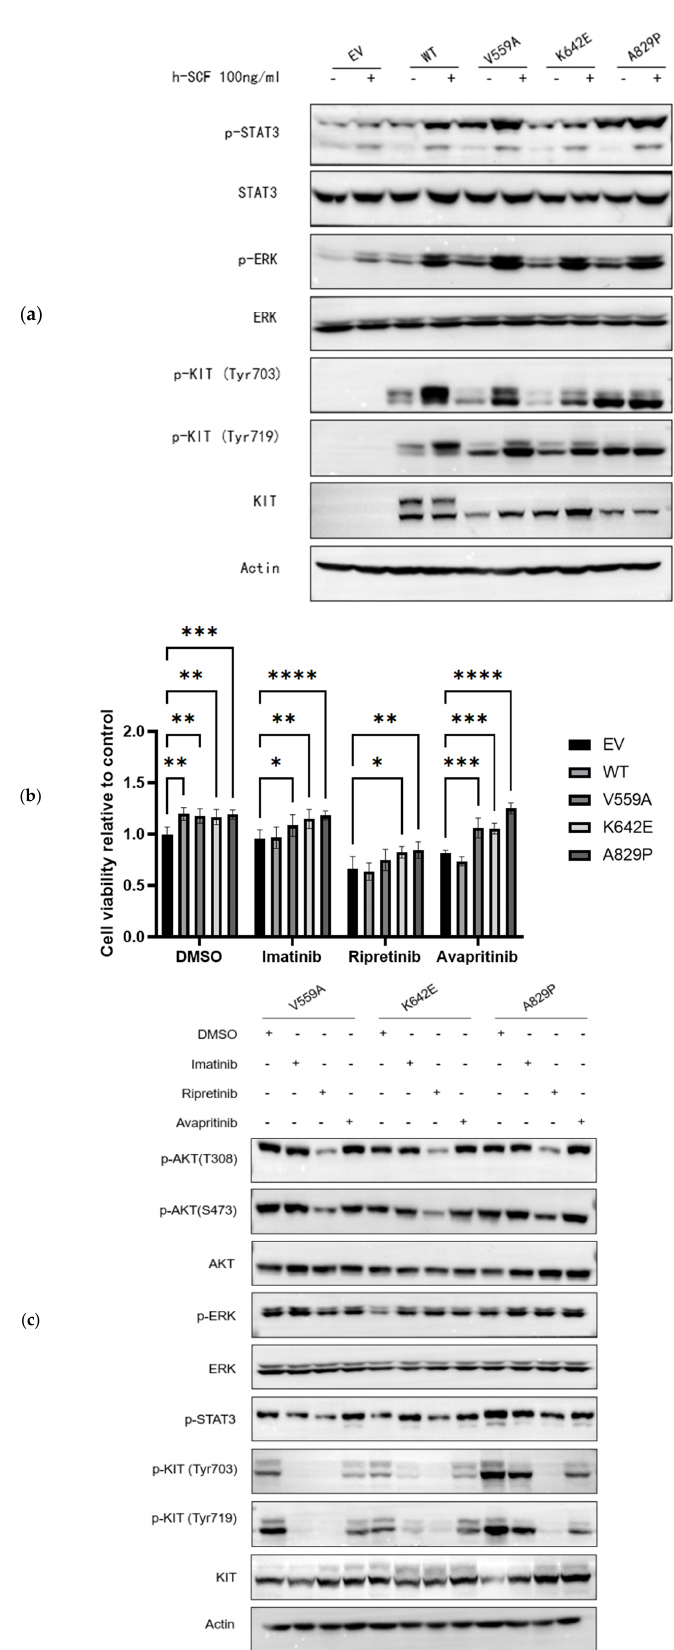
Figure 4. The successful construction of wild/mutant KIT overexpressed cells. ( a ) Immunocytochem- istry images showing the expression of KIT (green; nuclei: blue) in 293T cells. ( b ) Sanger sequenc- ing identified that mutant KIT had been successfully constructed and transfected into 293T cells. The total RNA was extracted from transfected cells, and reverse transcriptions were subsequently conducted. PCR experiments were used for amplifying targeted sequences. ( c ) Western blotting identified that the wild/mutant KIT proteins were successfully ex- pressed in stably transfected 293T cells.